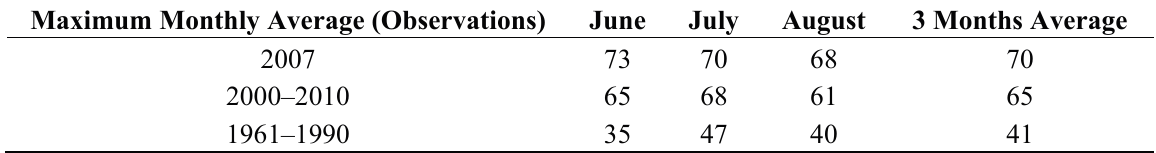
Table 1. Observed maximum monthly average of surface ozone (ppb) over Athens during June, July and August 2007, compared with observed monthly during the periods 2000–2010 and